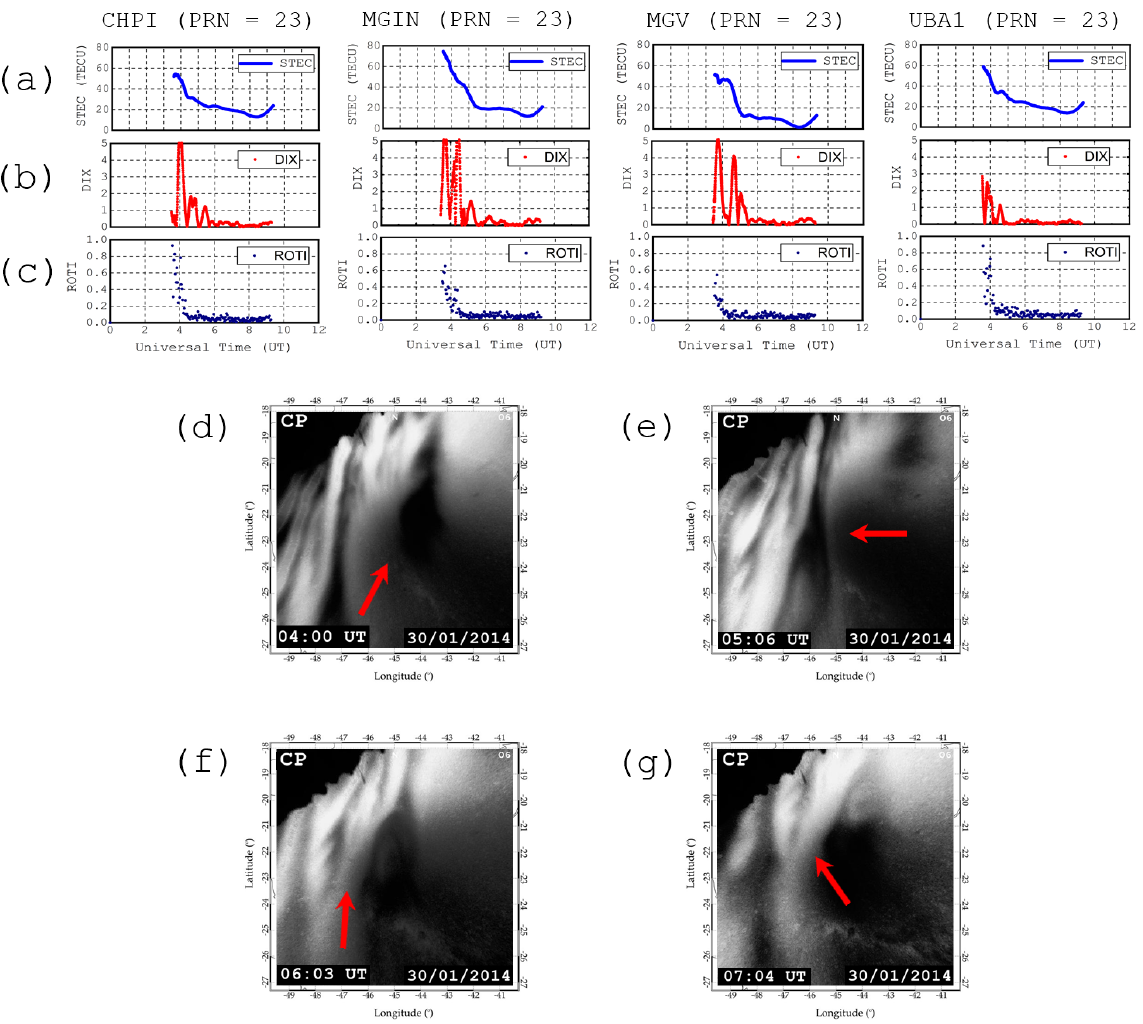
Figure 3. Relative STEC (a) , DIX (b) , and ROTI (c) for CHPI, MGIN, MGVA, and UBA1 observations, along with a sequence of OI 630nm airglow images taken at CP (d, e, f, g) during the same satellite PRN 23 tracking